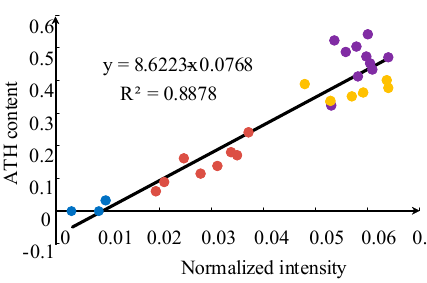
Figure 11. Normalized Al atomic line (Al I 308.2 nm) average intensity of samples with different ATH content; blue, red, yellow and violet points correspond to the silicone rubber samples classified as 1A0, 1A2.5, 1A3.5 and 1A4.5, respectively.